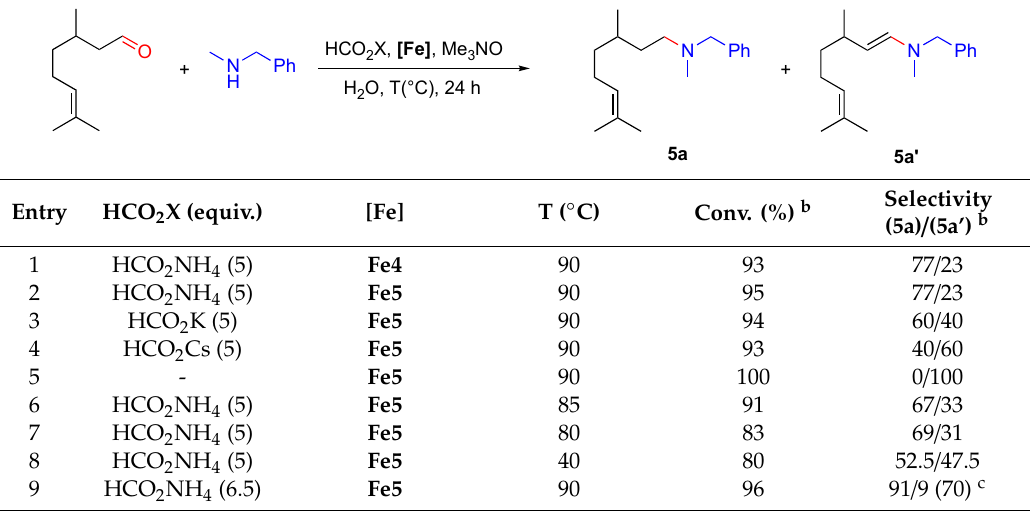
Table 3. Optimization of the reaction conditions for the reductive amination a .